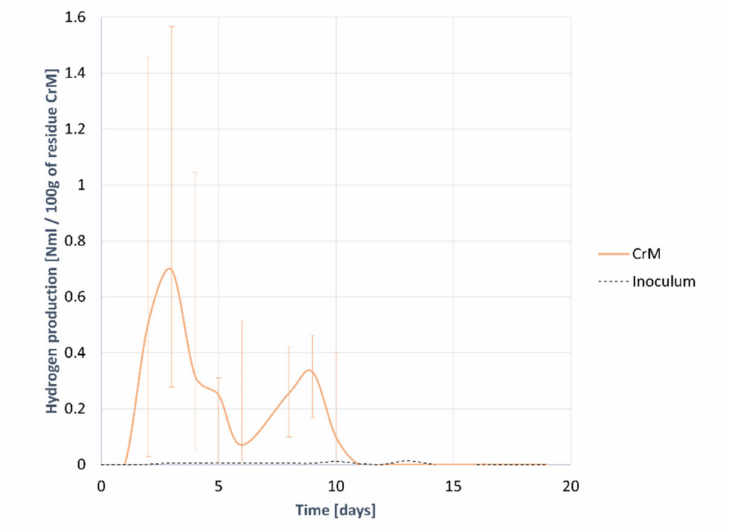
Figure 4. Gross hydrogen production mean curve from the anaerobic digestion of 100 g of residue